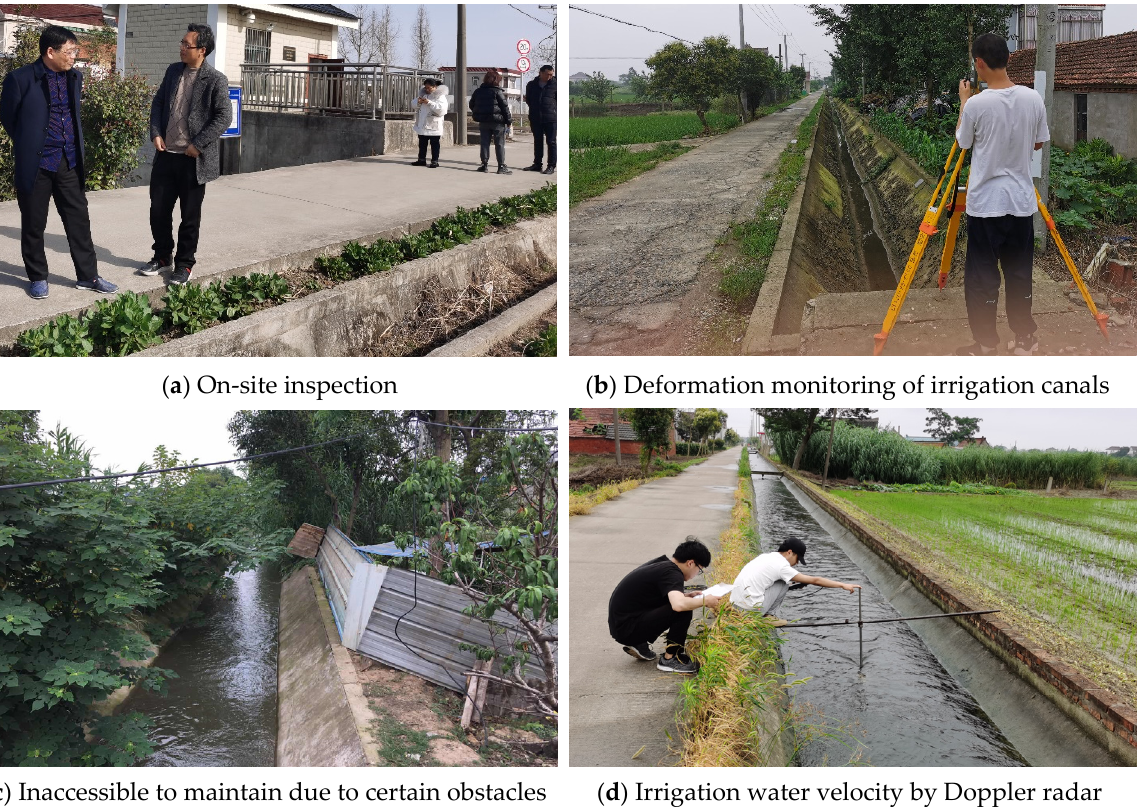
Figure 1. Traditional survey for FWCP maintenance in China.